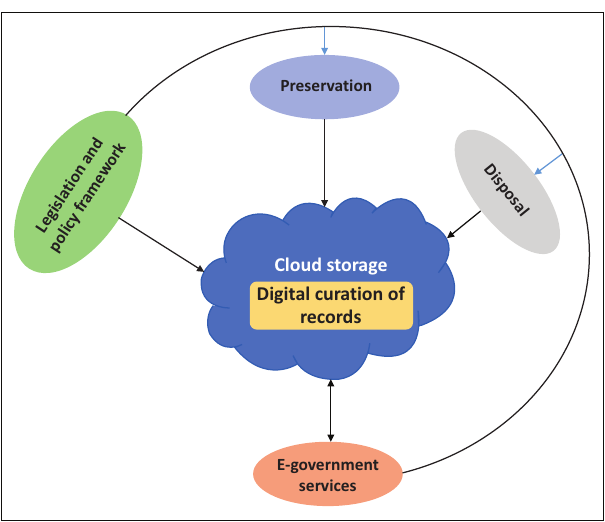
FIGURE 1: Framework for digital curation of